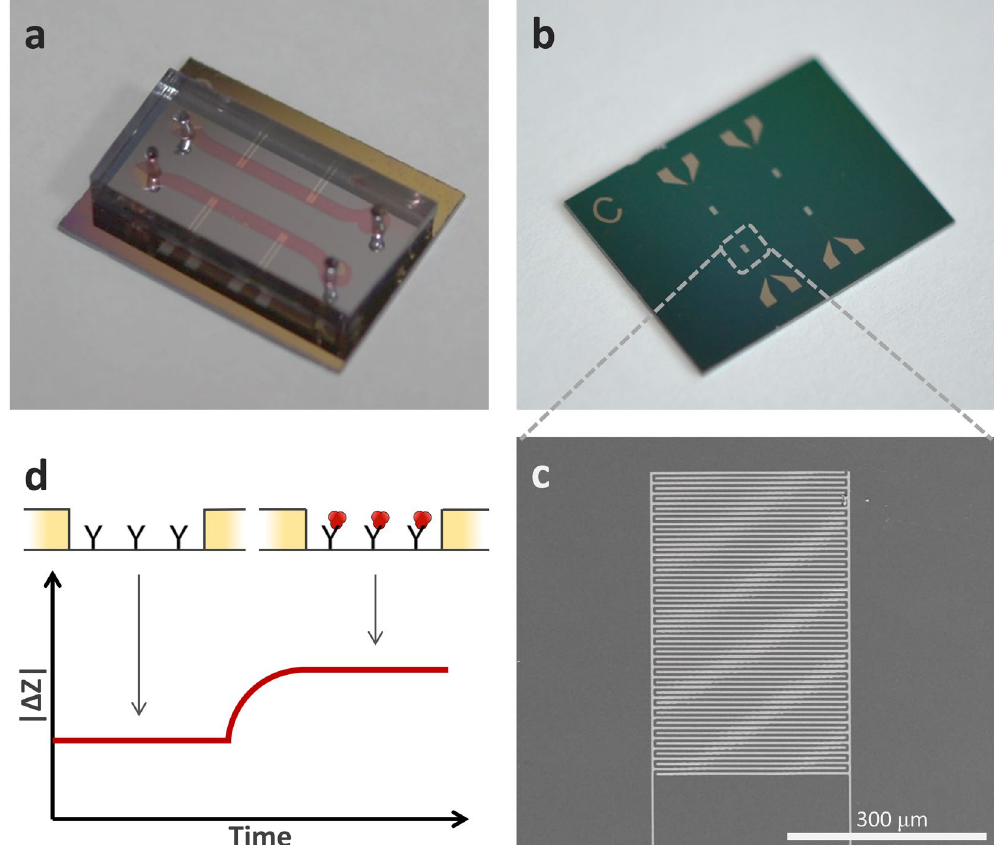
Figure 1. IME sensor scheme and sensing mechanism. ( a ) Medium-changeable microfluidic-channel- integrated device. ( b ) Image of the IME device. ( c ) SEM photograph of one IME pair. ( d ) Sensing mechanism for increase in impedance of the IME by interaction between A β and